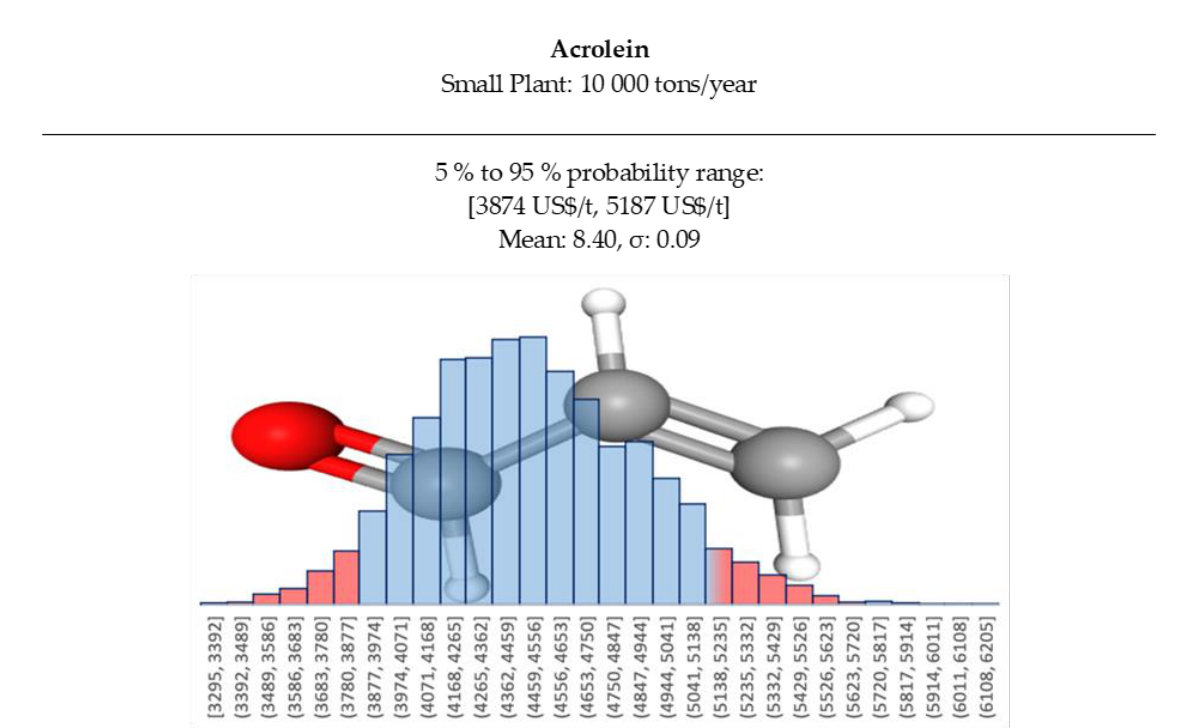
Figure 13. Acrolein prices Log-Normal distributions for small plant case. For acrolein, due to limited data, the historical correlations of acrolein/methanol and acrolein/ethanol for small and big plants are probably not relevant (0.2 and 0.001 for the big, and 0.5 and 0.45 for the small plants, respectively). For this reason, bridging through propylene and crude oil, we assumed an acrolein/methanol and acrolein/ethanol correla- tion coefficient of 0.2 in the future. The correlation matrix is reported in Table 4.